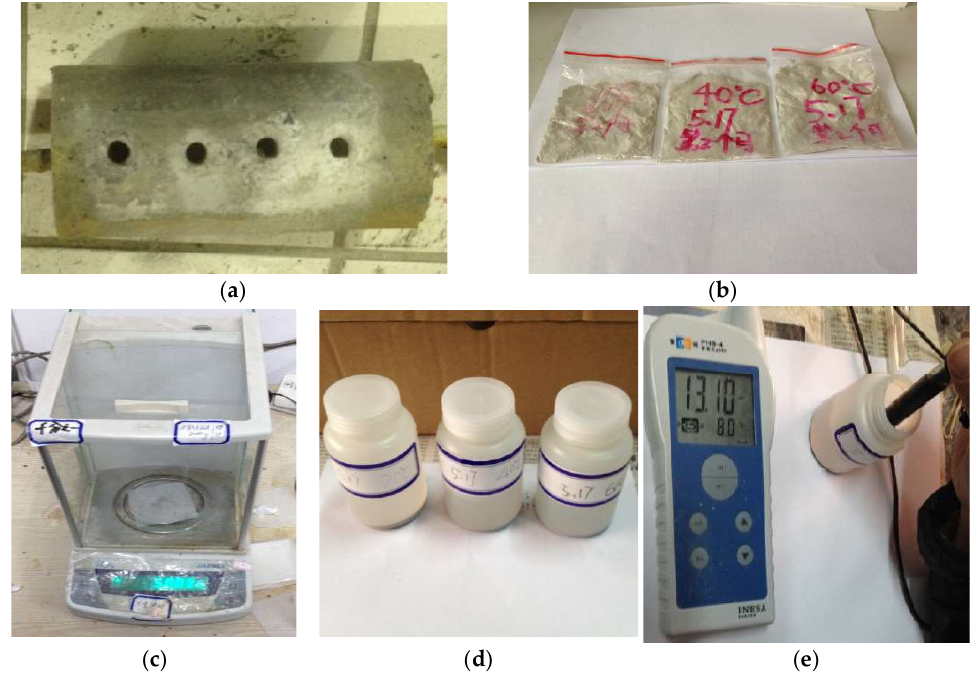
Figure 5. Determination of pH value of pore solution in concrete: ( a ) Hole drilling; ( b ) Concrete powder after aging for 60 days; ( c ) Weight after sieving; ( d ) Solution; ( e ) pH analysis.